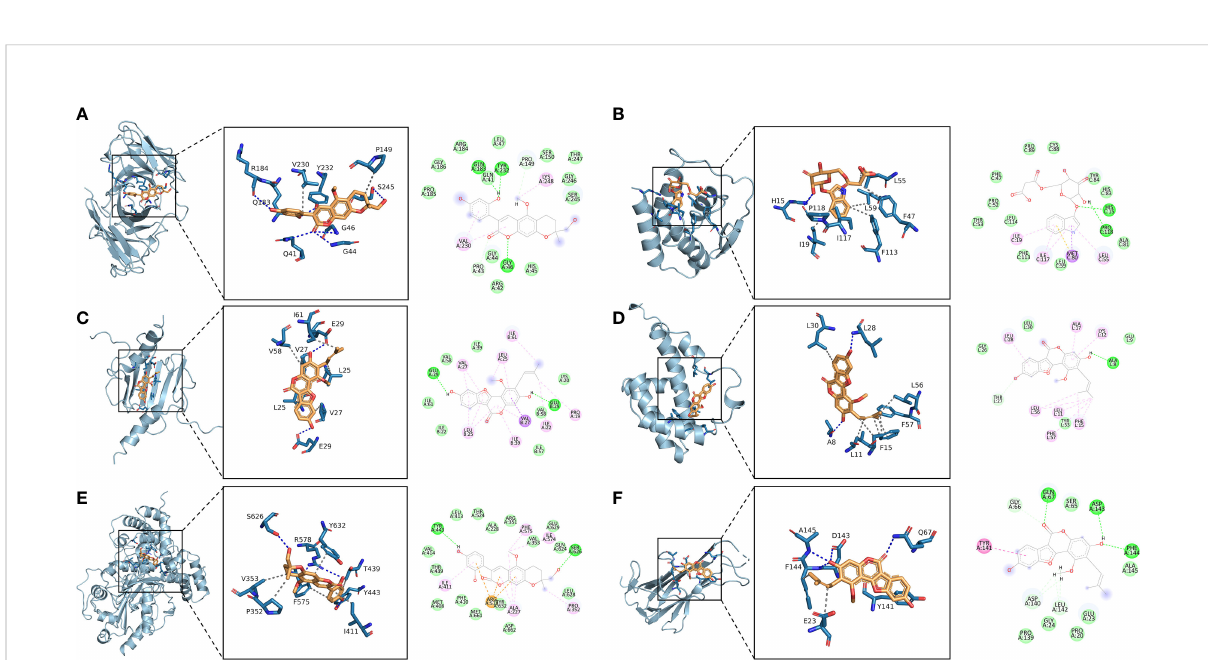
FIGURE 5 Binding conformation of active ingredients and protein targets. (A) CCR5/Licopyranocoumarin, (B) CSF2/3-3-Oxopropanoic acid, (C) CXCL8/ Glycyrol, (D) IFNG/Glycyrol, (E) NLRP3/Licopyranocoumarin, (F)